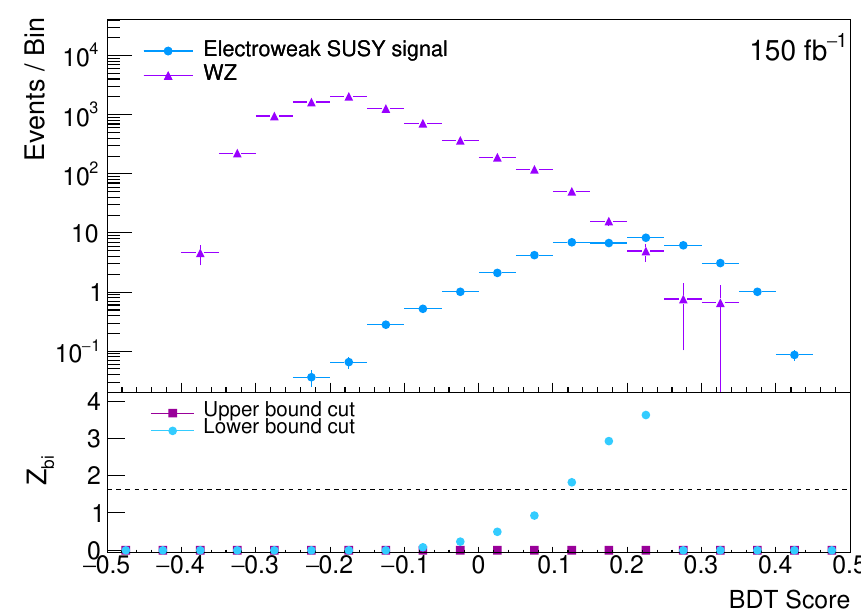
Figure 11. Distributions of the BDT score for electroweakino signal and WZ background events, in the case where the BDT is only trained on kinematic variables. In the lower panel the Z bi is also shown for cumulative upper or lower bound cuts on the score. Events in the overflow bin are not shown in the distribution but are included in the Z bi calculation. Note that we deliberately set Z bi to zero in the lower figure when the number of signal or background events falls below three (before